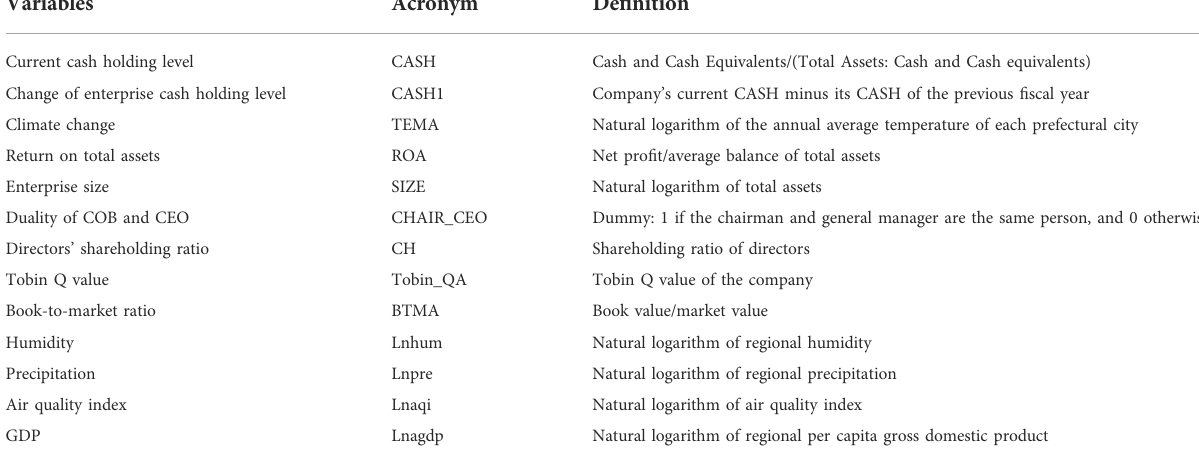
TABLE 1 Variables